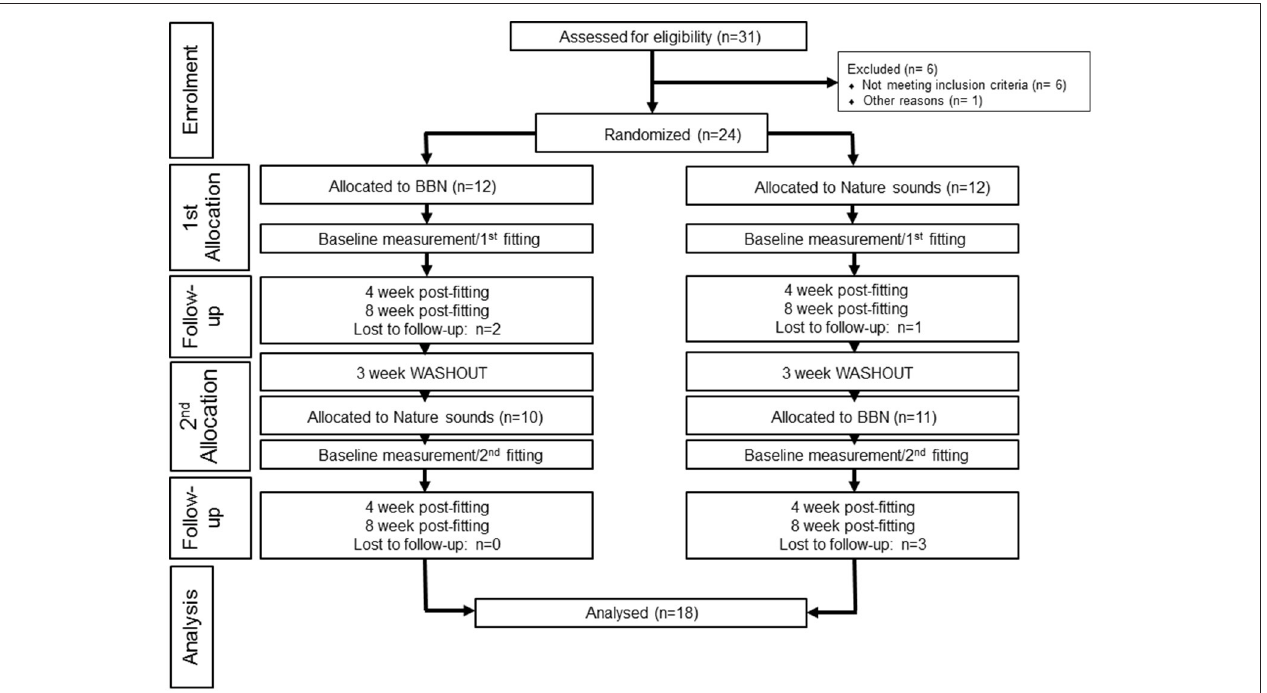
FIGURE 2 | CONSORT flow diagram of